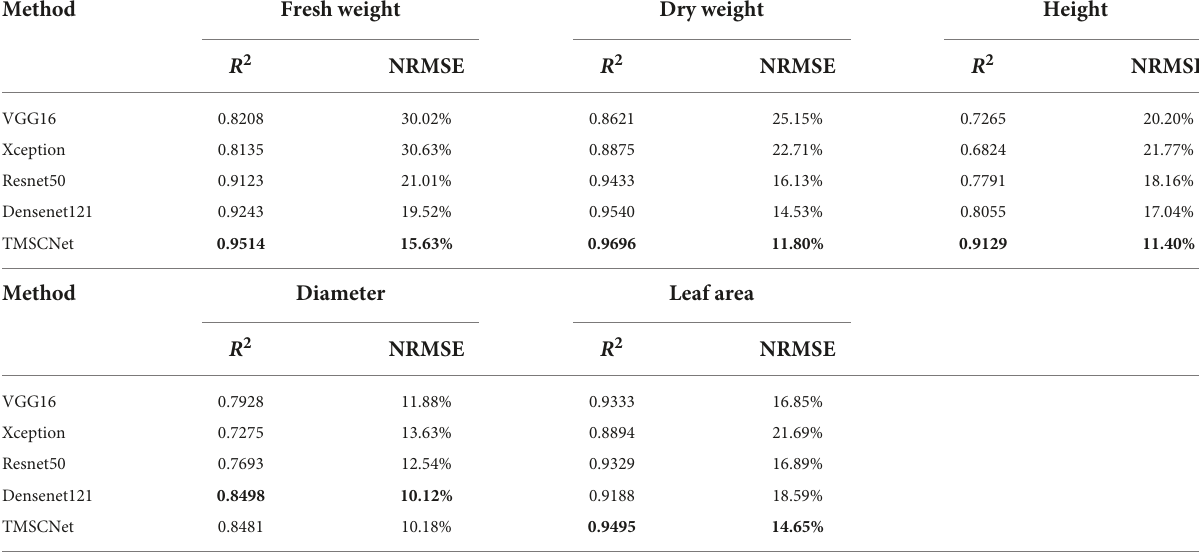
TABLE 6 R 2 values and NRMSE values of the estimated lettuce traits by different classical CNNs and